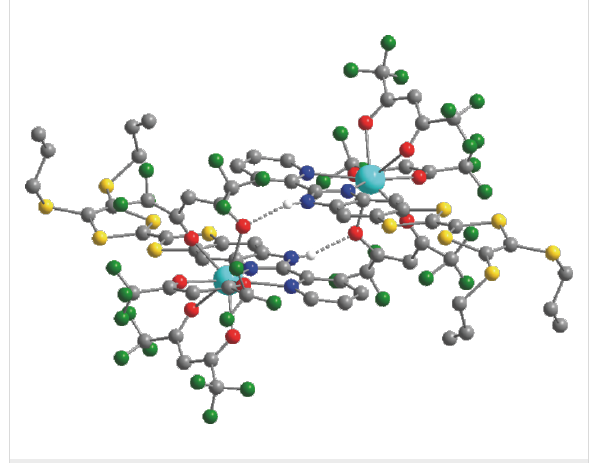
Figure 3: Representation of supramolecular interactions in Dy1 . Dy, O, N, C, S and F atoms are depicted in light blue, red, blue, grey, yellow and green, respectively. H atoms (except the H atoms involved in hydrogen bonds) are omitted for